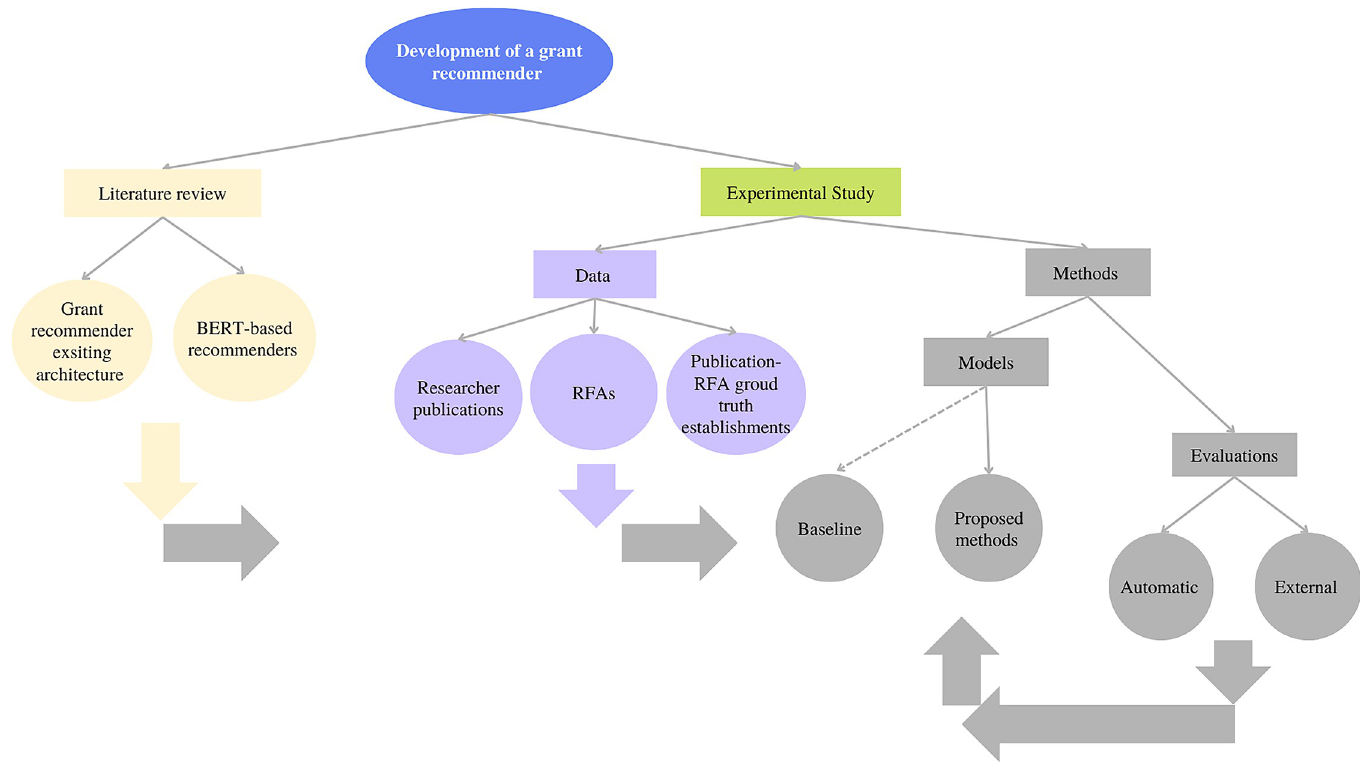
Fig 1. Research methodology